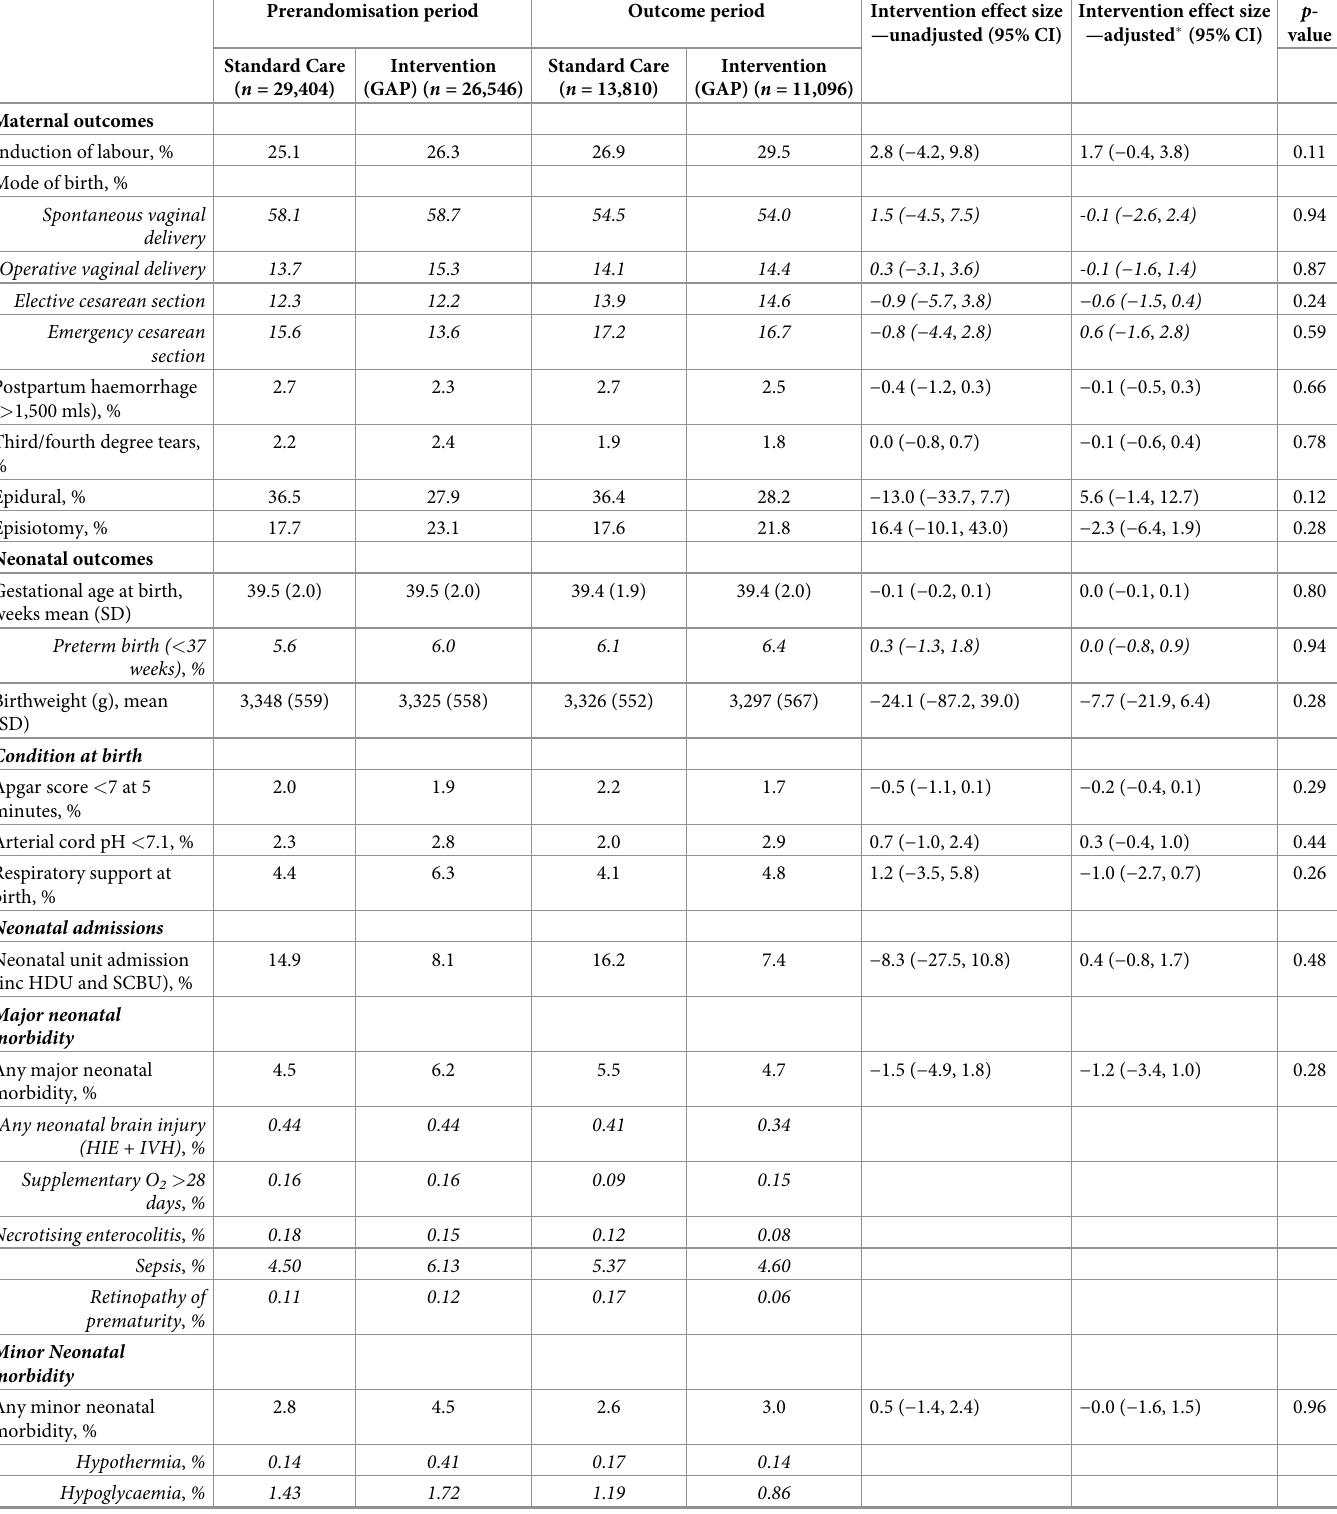
Table 5. Secondary clinical outcomes according to treatment allocation (mITT analysis). Prerandomisation